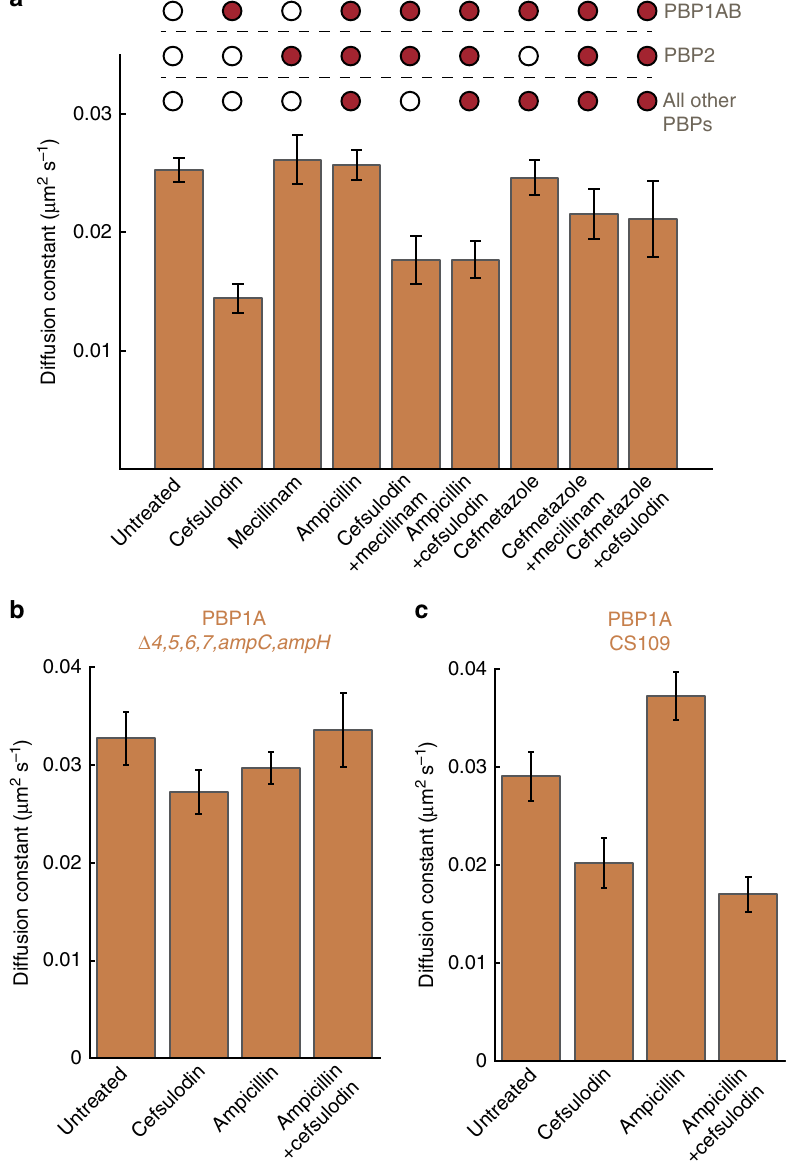
Figure 2 | PBP1A diffusion depends on its enzymatic activity and interactions with other PBPs. ( a ) Apparent diffusion constants of PAmCherry-PBP1A molecules (TKL241) imaged on agarose pads containing b -lactam antibiotics (100 m gml (cid:2) 1 each). The canonical targets for each antibiotic are indicated with filled red circles. ( b ) Apparent diffusion constants of PAmCherry-PBP1A molecules imaged in CS612, a strain containing multiple deletions for PBPs (CS109 D dacB / pbp4 D dacA / pbp5 D dacC / pbp6 D pbpG / pbp7 D ampC D ampH ) on agarose pads containing various antibiotics. ( c ) Apparent diffusion constants of PAmCherry-PBP1A molecules imaged in the wild-type strain background CS109. Error bars indicate the s.d. of 1,000 bootstrap